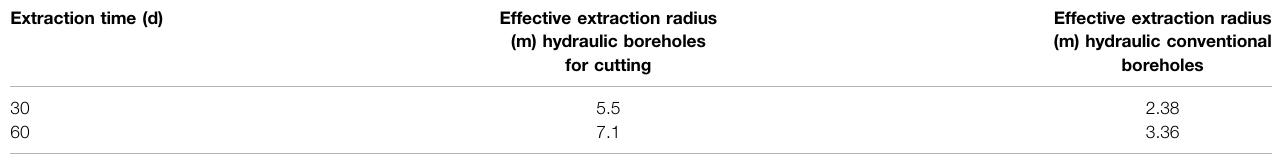
TABLE 4 | Comparison of the effective extraction radiuses around boreholes for hydraulic cutting and conventional boreholes. Extraction time